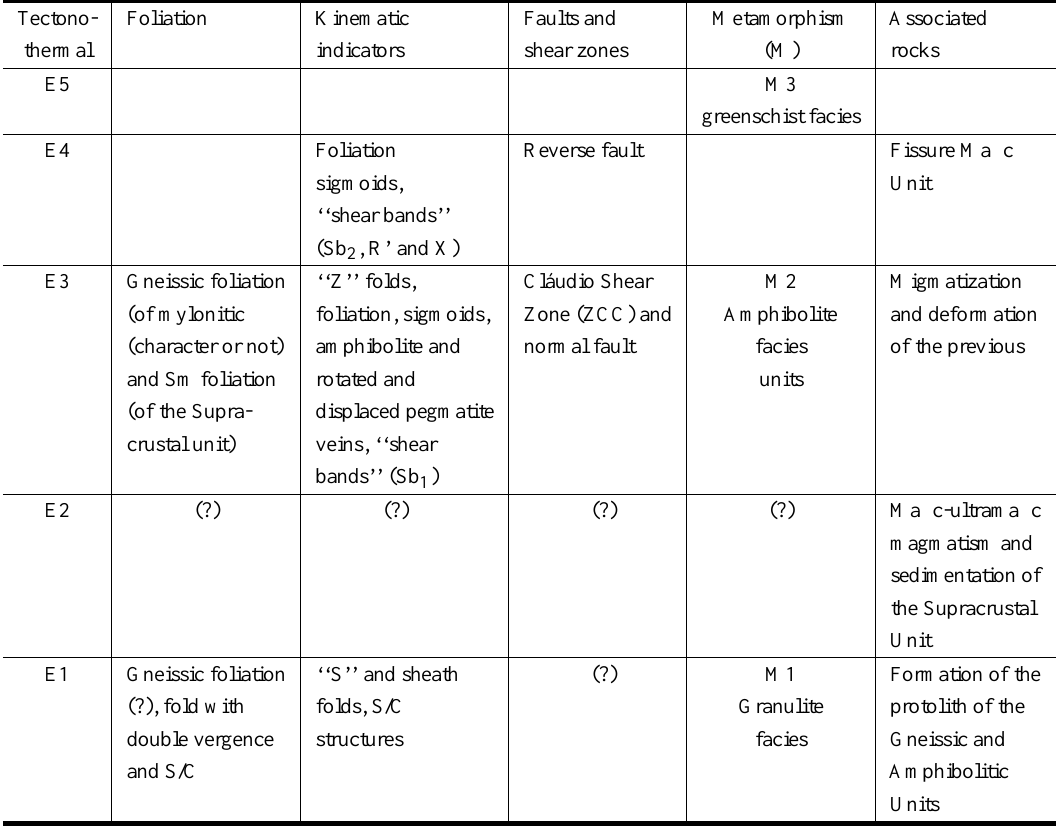
Simplified table of the structural elements associated with the tectonothermal